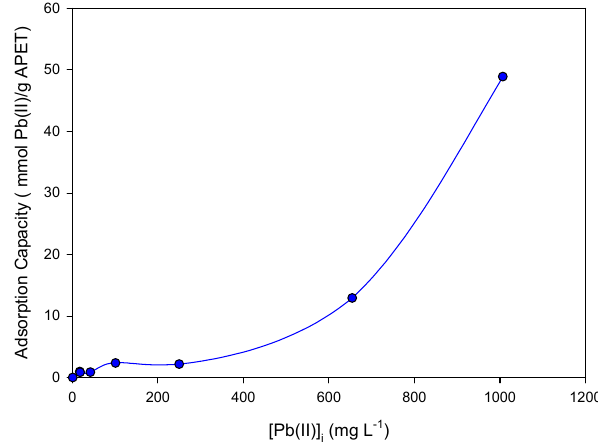
Figure 6. Effect of the initial concentration on the Pb(II) adsorption with aminated poly(ethylene terephthalate) (APET) nanofiber mats.